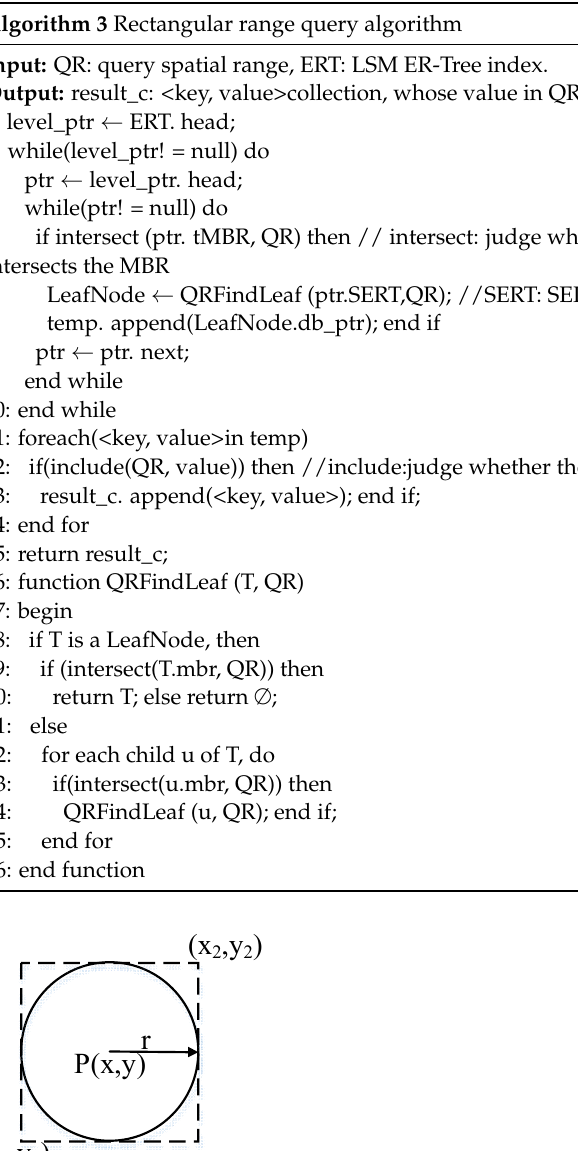
Algorithm 3 Rectangular range query algorithm